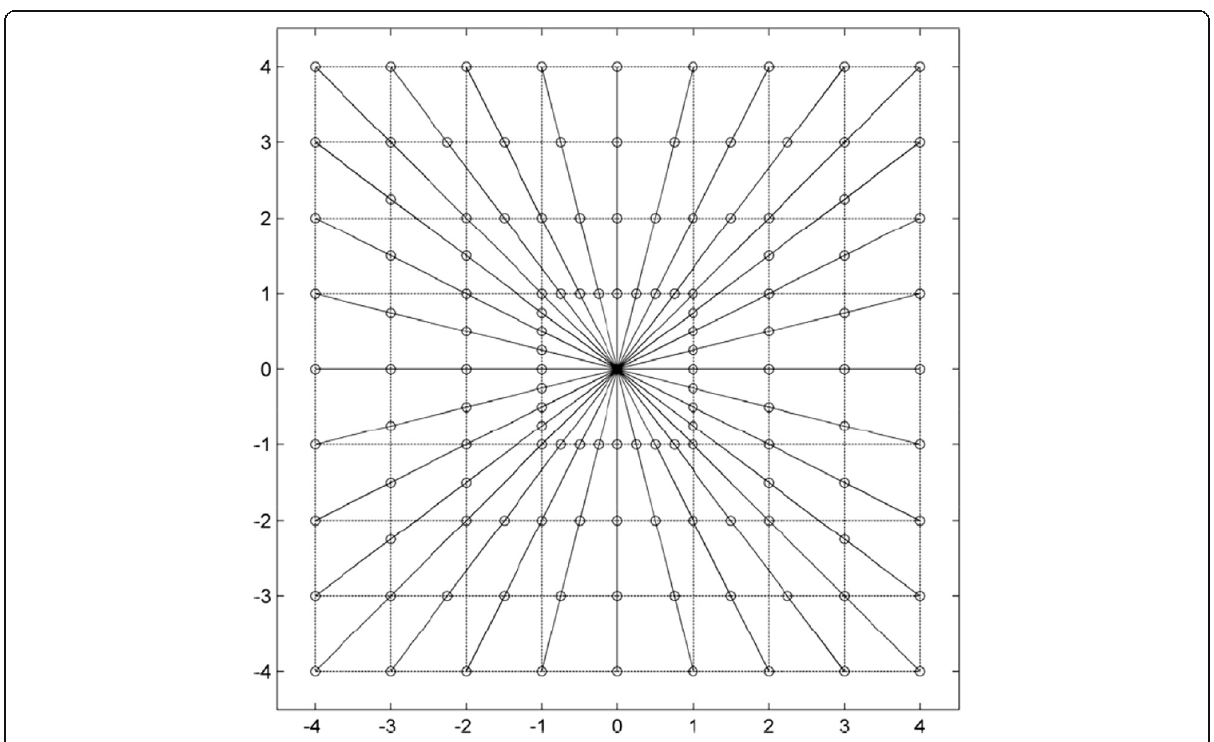
Fig. 3 Ridgelet transform calculation using FFT in